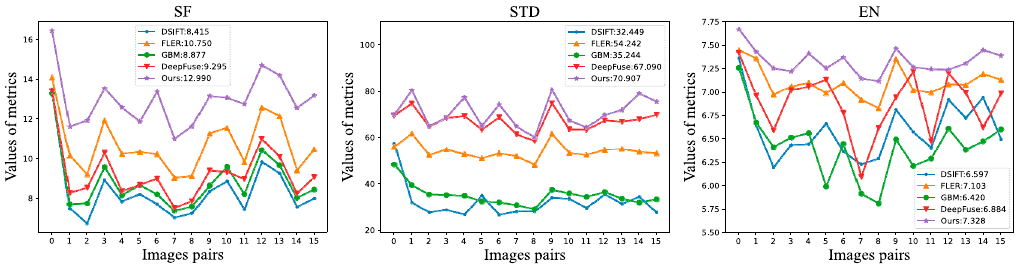
Figure 6. Quantitative comparisons of the SF, STD, and EN on 16 image pairs from our dataset.